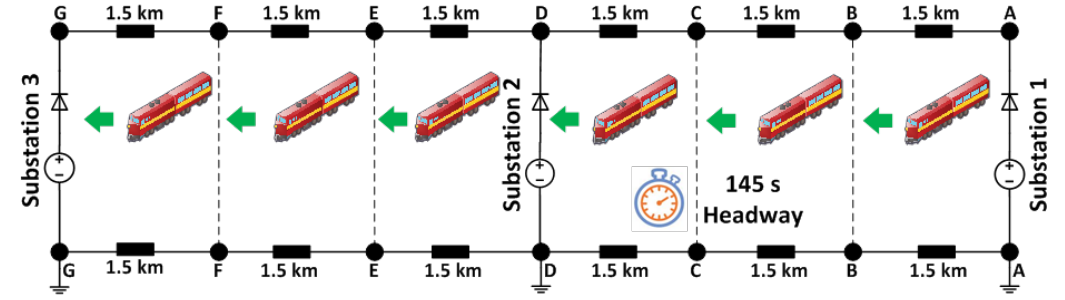
Figure 1. Single railway track with three substations and six running trains. Six trains are modelled and are staggered by a time shift (known as headway) of 145 s. The trains start their journeys at Station A and finish their journeys at Station G. To demonstrate electrical validation, the journeys are repetitive and the characteristics and loads are the same for all trains. However, in order for the model to simulate realistic electric railways, real traffic scenarios need to be